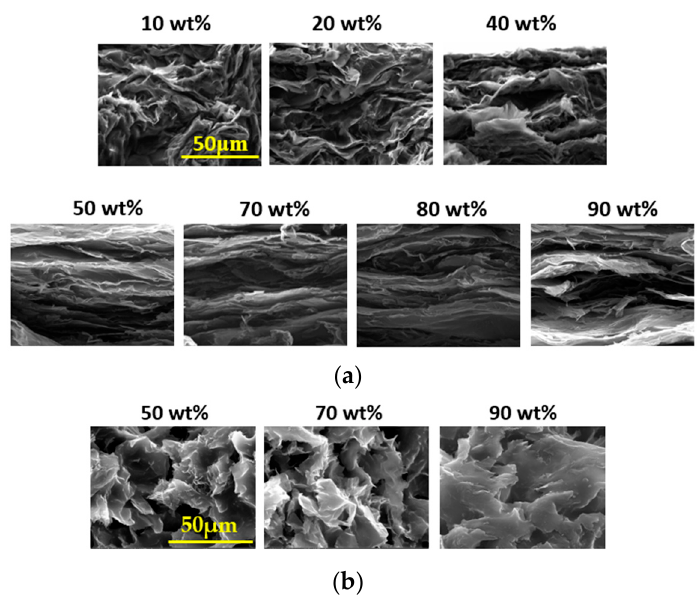
Figure 3. SEM images of “compact” ( a ) and “porous” ( b ) samples at various filler contents. The results of the X-band waveguide measurements are reported in Figure 4. A comparison limited only to the thin compact (i) and porous samples (iii) for different filler contents is reported.